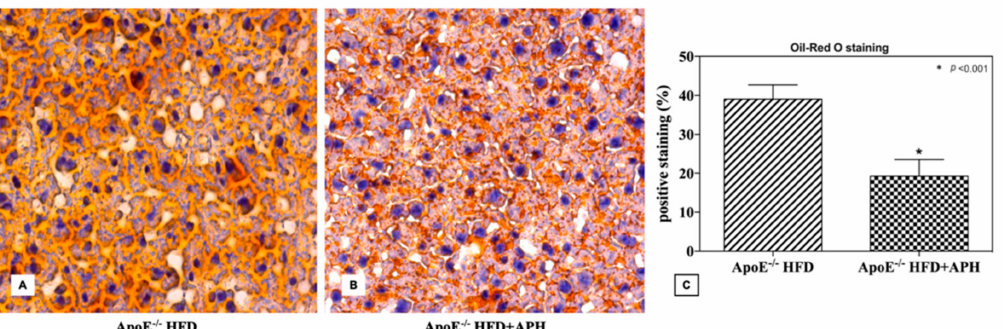
Figure 5. Representative liver sections ( A , B ) and quantification (% of positive stained area) of Oil-Red O histological staining ( C ). ApoE – / – mice fed a HFD showed a statistically twofold increase in hepatic fat accumulation (39.06 ± 3.67%) compared to ApoE – / – mice fed with a APH diet (19.26 ± 4.32%). Data are presented as mean ± SD for n = 6 mice per group (Scale bar, 50 µ m). Abbreviations: HFD high-fat diet, APH anchovy protein